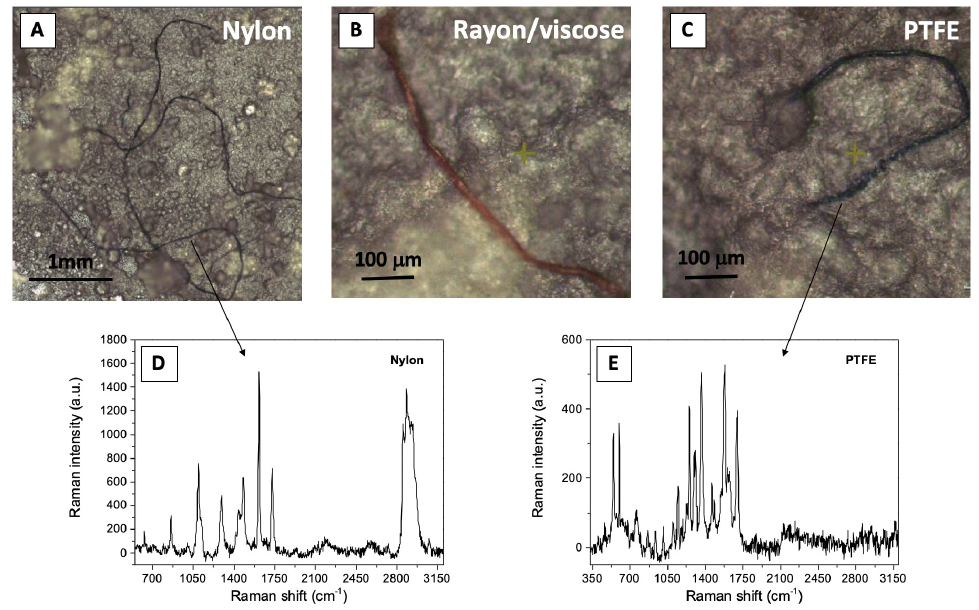
Figure 4. Optical images of different kinds of filaments found on the surface of the membranes and identified as: ( A ) nylon, ( B ) rayon/viscose, and ( C ) polytetrafluoroethylene. ( D , E ) Raman spectra for the two black filaments shown in ( A , C